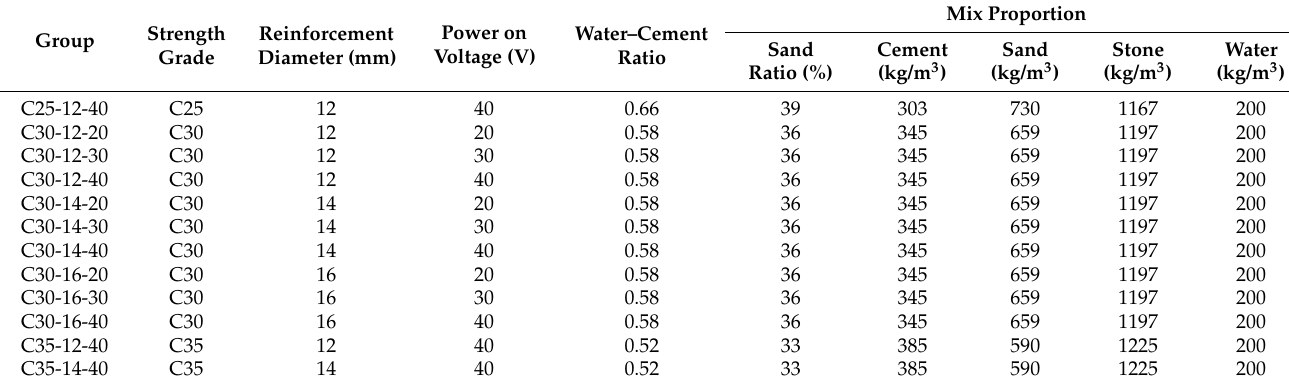
Table 2. Test grouping and mix proportion.